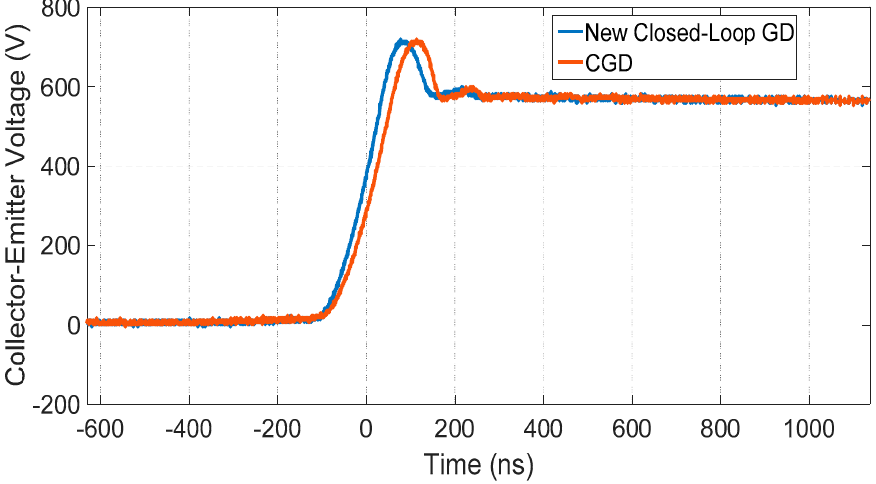
Figure 8. The resultant V CE from closed-loop GD and CGD at turn-off condition.